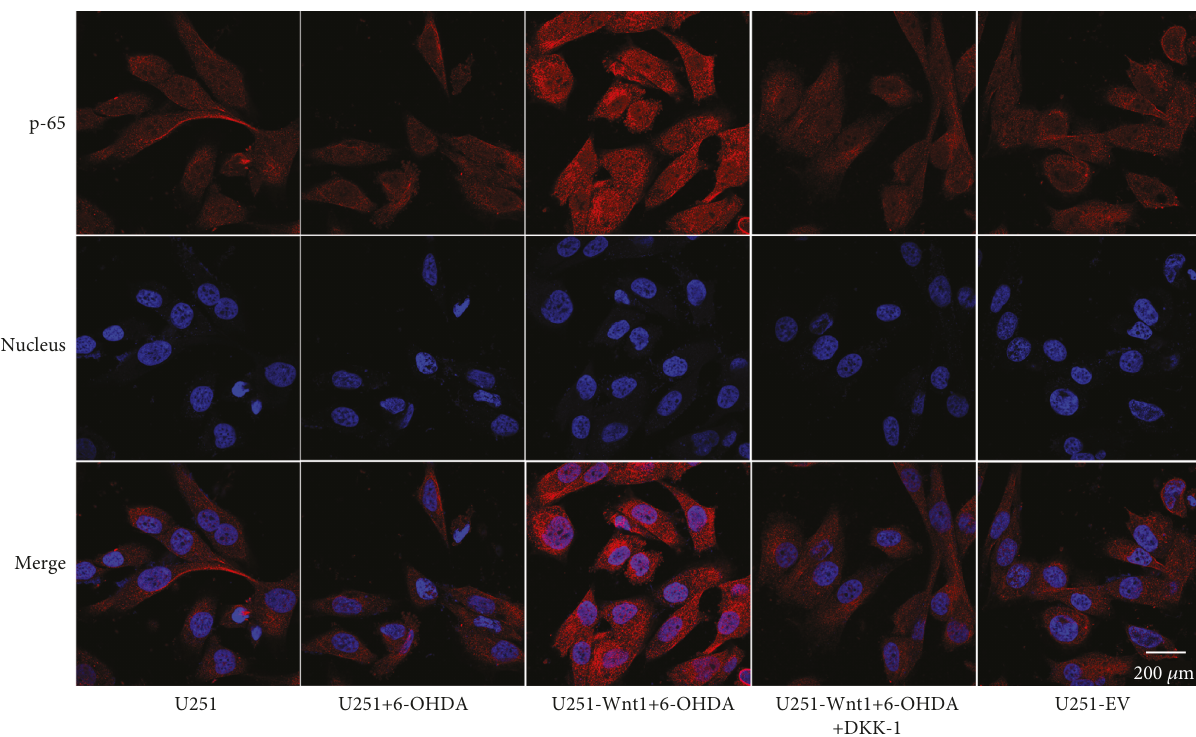
Figure 9: Immuno fl uorescence staining of p65 protein in U251 cells. U251 cells, U251-Wnt1 cells, or U251-EV cells were treated with vehicle, 6-OHDA (50 μ M), or/and DKK-1 (100ng/ml) for 24 h, and the expression and distribution of p65 were examined using an antibody against p65 (red). Nuclei were counterstained with DAPI (blue). All images were captured using a confocal laser scanning